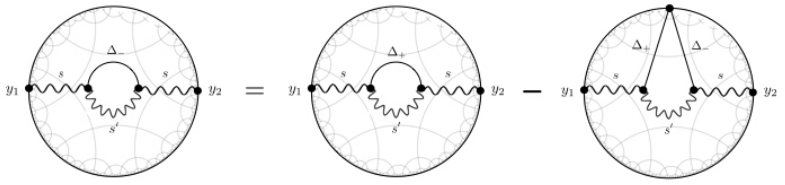
Figure 9a. Diagrammatic relation between bubble diagrams with di(cid:11)erent conformal boundary conditions on the scalar propagating inside the loop. For s 0 > 0, they di(cid:11)er by a single-cut of the scalar internal line.